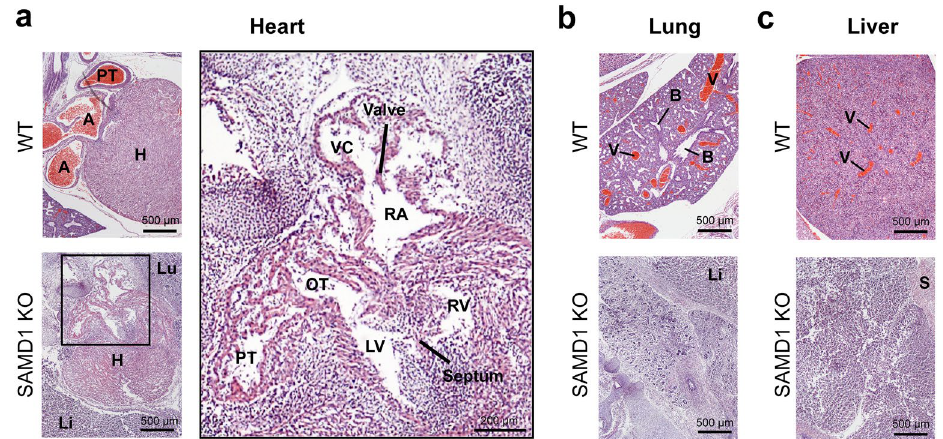
Figure 2. SAMD1 KO embryos exhibit organ degradation. ( a ) H&E staining of the heart at E14.5. H heart muscle, A aorta, PT pulmonary trunk, Lu lung, Li liver, RA right atrium, OT outflow tract of left ventricle, VC vena cava, LV left ventricle, RV right ventricle. ( b ) H&E staining of the lungs at E14.5. B bronchiole, V blood vessel, S skeletal muscle. ( c ) H&E staining of the liver at E14.5. V blood vessel, S skeletal